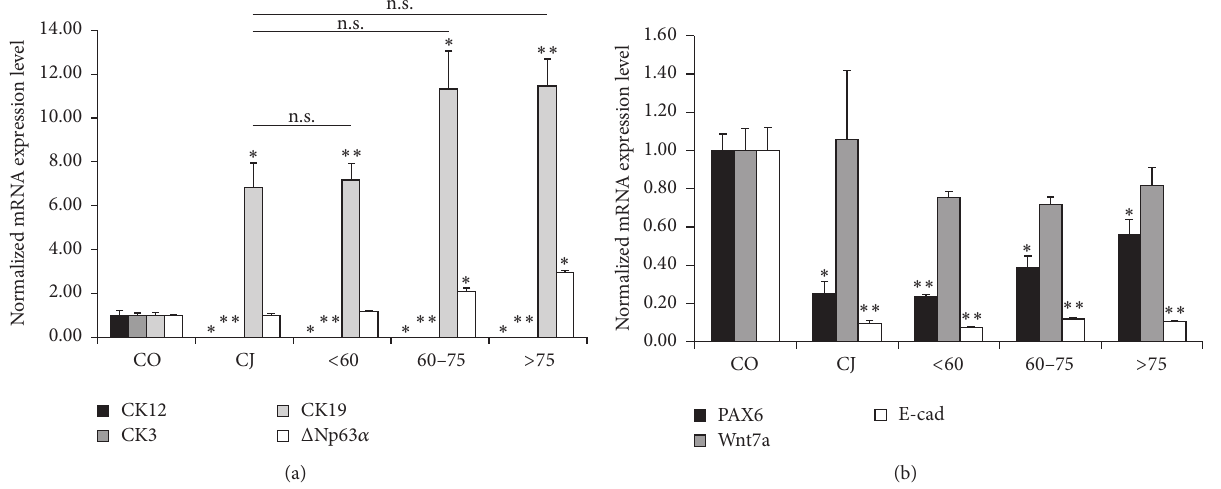
Figure 1: Comparative qPCR analysis of corneal progenitor and differentiation markers in LSC pools. (a) mRNA expression of CK12, CK3, CK19, and Δ Np63 𝛼 . (b) mRNA expression of PAX6, Wnt7a, and E-cad. Results are presented as mean ± SE from 3 independent experiments. Statistical analysis was performed using two-tailed Student’s 𝑡 -tests ( ∗ 𝑝 < 0.05 ; ∗∗ 𝑝 < 0.01 ; and ns: not significant). CJ: conjunctiva cells; CK: cytokeratin; CO: corneal epithelial cells; E-cad: E-cadherin.